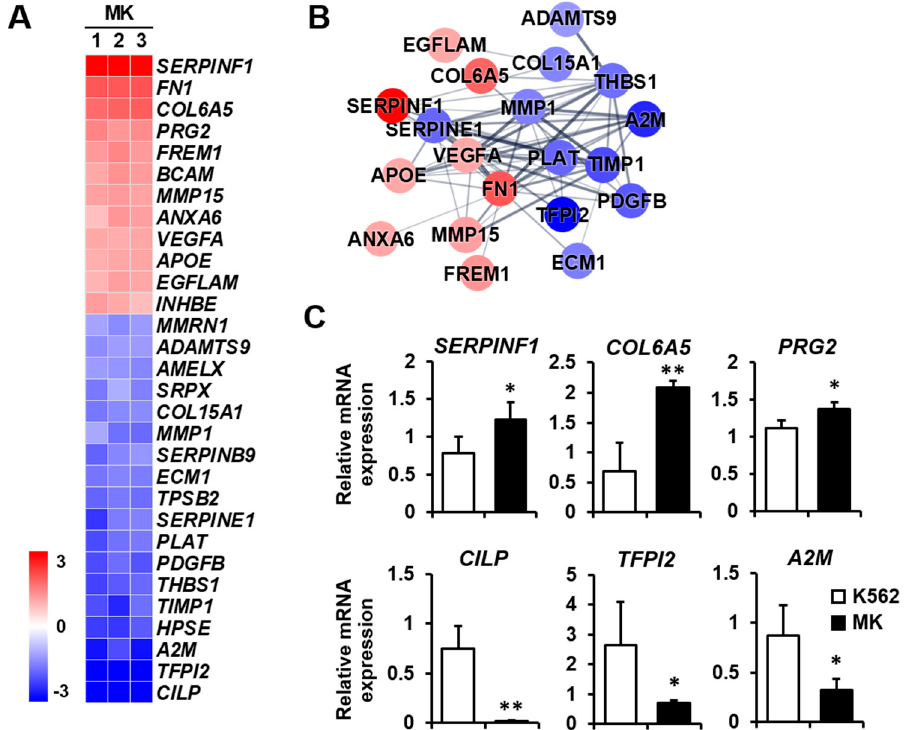
Figure 6. Expression levels by z-scores of genes included in the extracellular matrix cluster and the relationship between constituent genes. ( A ) Heat map of genes differentially expressed in megakaryocytes (MKs) compared with K562 cells based on the microarray analysis. The red color indicates upregulation and the blue color indicates downregulation. The degrees of colors represent the expression levels of the genes. ( B ) Protein–protein interaction analysis using the STRING database. The red and blue colors denote upregulation and downregulation, respectively. The higher the confidence in the interaction, the greater the line thickness between the proteins. Members without interaction with other genes were excluded from the STRING database analysis. ( C ) Validation of the mRNA expression of selected genes ( SERPINF1, COL6A5, PRG2, CILP, TFPI2, and A2M ) differentially expressed in MKs by qPCR. Relative expression levels were plotted against gene expression levels in K562 cells. Data are presented as the mean ± standard deviation of three independent experiments. Please see abbreviations for the full names of genes. *, p < 0.05; **, p < 0.01 versus K562 cells.